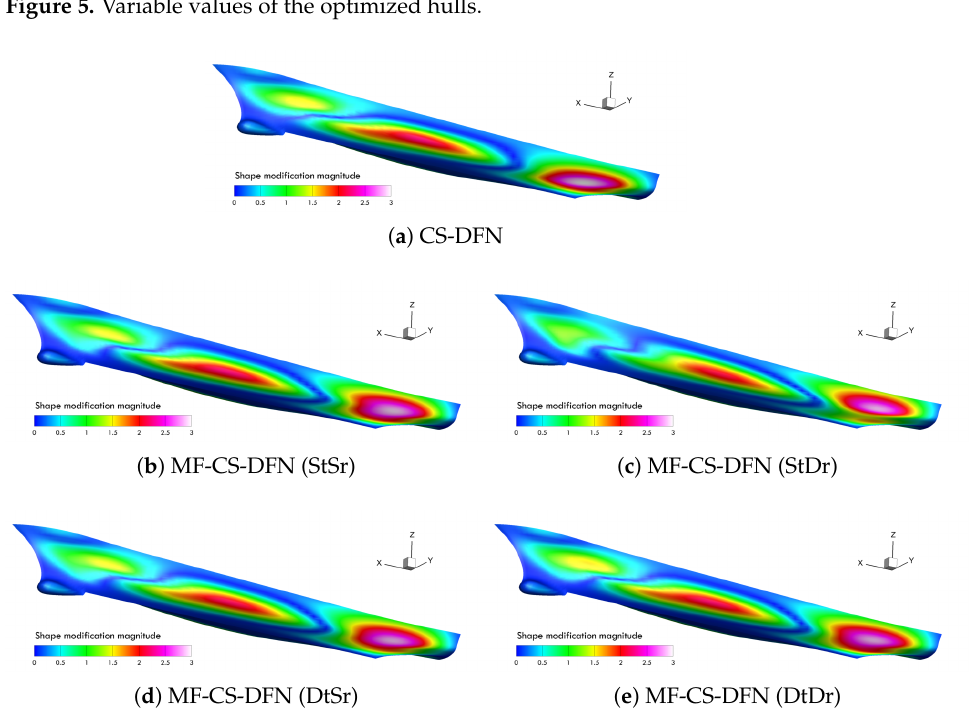
Figure 6. Shape modification magnitude of the optimized hulls with respect to the parent